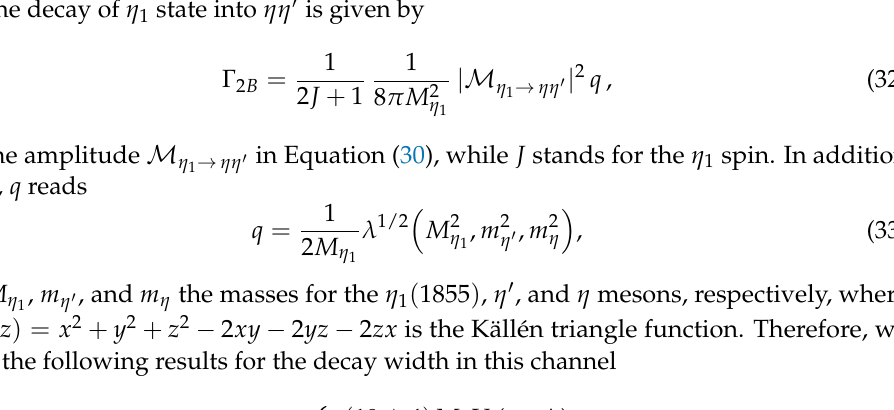
ηη (cid:48) decay through the K 1 ¯ K →